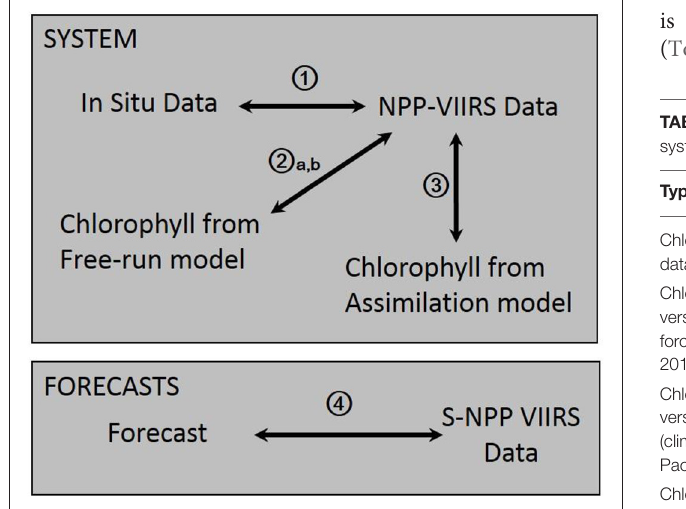
FIGURE 1 | Diagram describing the different procedures used to characterize bias and uncertainties in the system and forecasts described in this study.